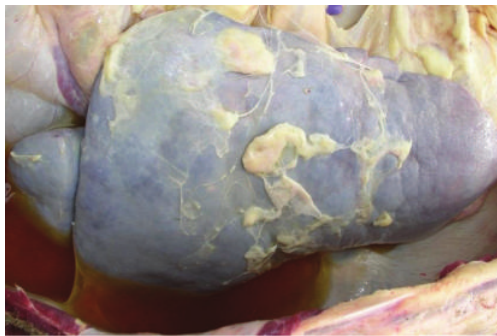
Figure 17: Postmortem view of the hepatomegaly along with fibrin shreds on its parietal surface.